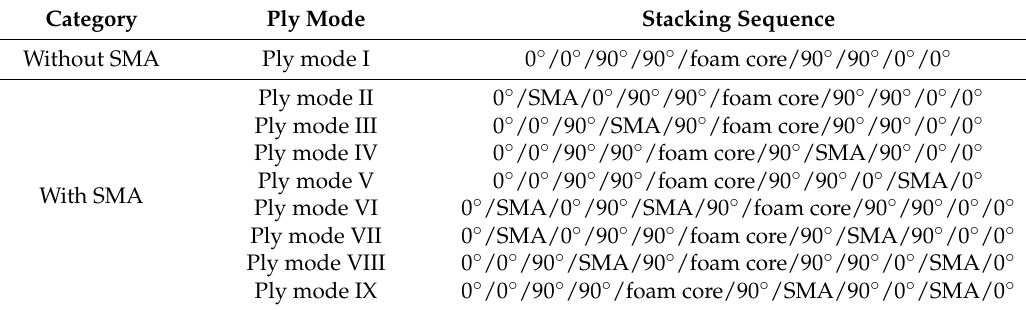
Table 2. The specific locations of the SMA wires in the sandwich panels.